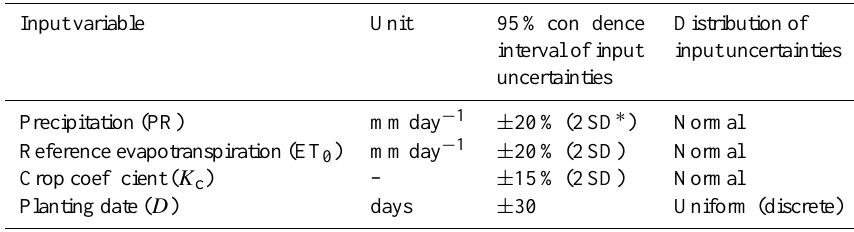
Table 2. Input uncertainties for crop water footprint accounting in the Yellow River basin.